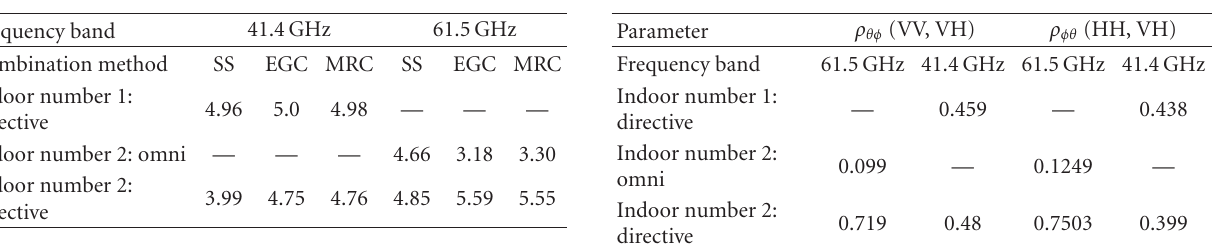
Table 3: Fading correlation